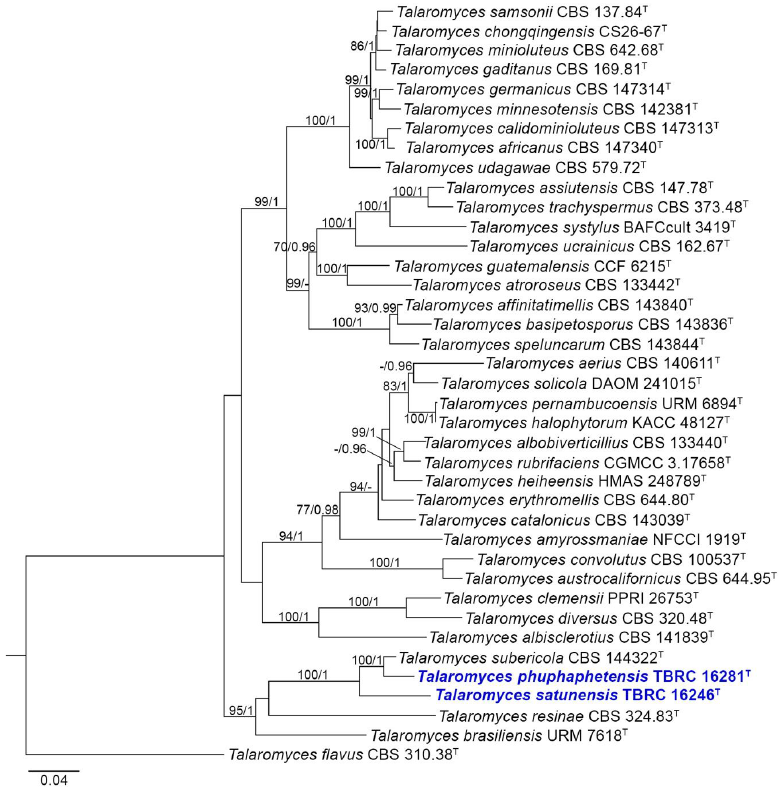
Figure 3. Maximum likelihood phylogeny based on the combination of the ITS region and BenA , CaM, and RPB2 genes for the closely related species belonging to Talaromyces section Trachyspermi . Talaromyces flavus (CBS 310.38) was chosen as an outgroup taxon. New species are indicated in blue. T = Ex- type strain. Bootstrap (BS) values ≥ 70% ( left ) or posterior probability (PP) values ≥ 0.95 ( right ) are indicated at the nodes.